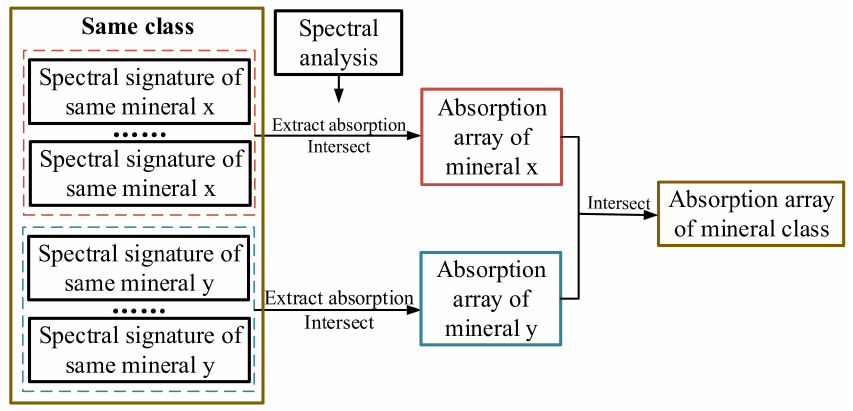
Figure 5. Process diagram of the custom spectral